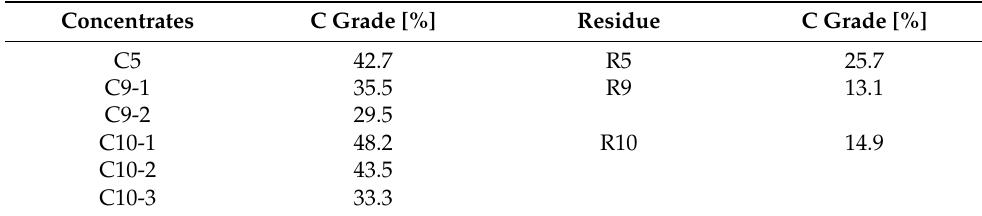
Table 4. C grades of flotation concentrates and residues after improving